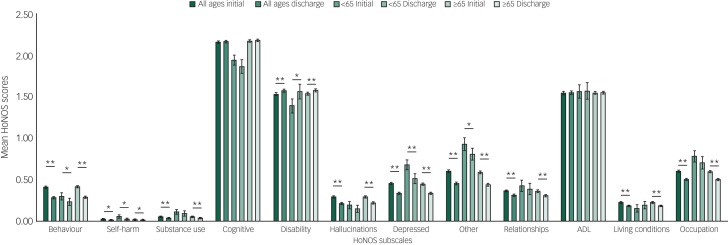
Organic disorder group: mean Health of the Nation Outcomes Scales (HoNOS) scores on initial assessment and discharge across the 12 HoNOS subscales.